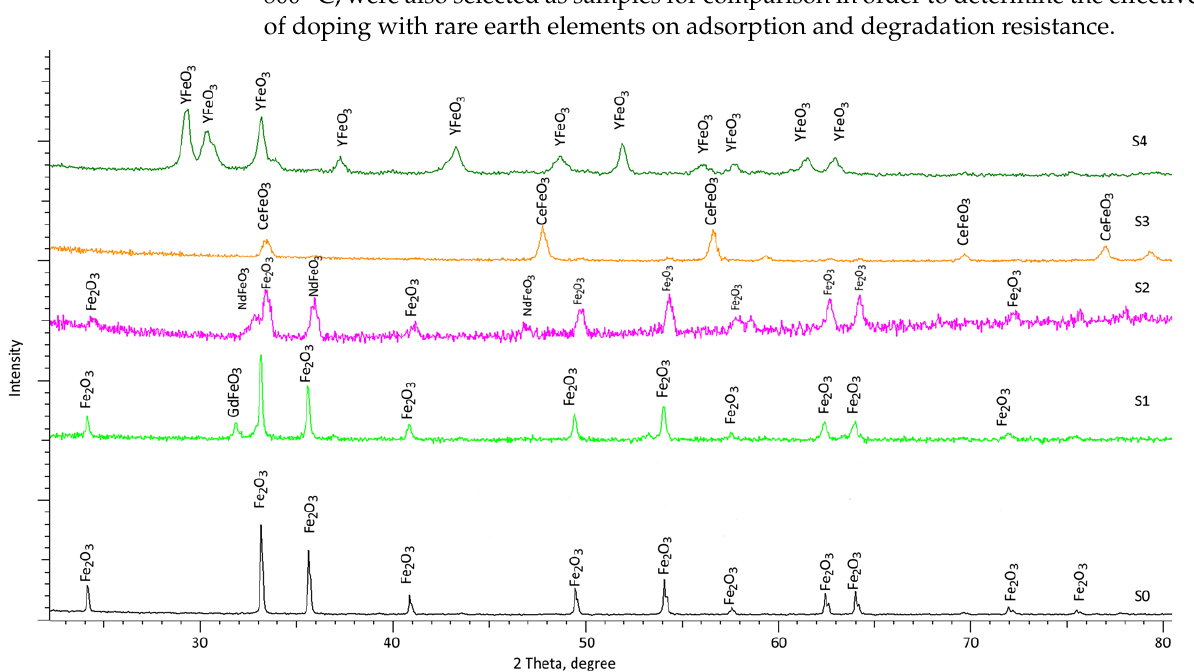
Figure 2. Characterization results of the phase composition of synthesized objects of study: S0—Fe 2 O 3 nanoparticles; S1—Fe 2 O 3 @GdFeO 3 nanoparticles; S2—Fe 2 O 3 @NdFeO 3